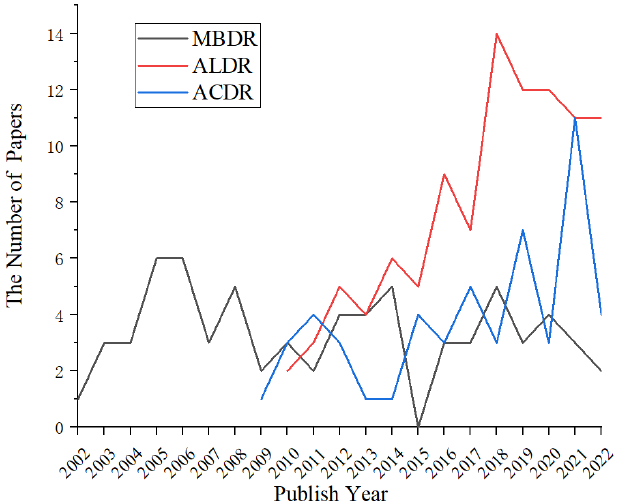
Figure 13. Variation trends in the number of papers published on the three drag reduction tech- nologies.